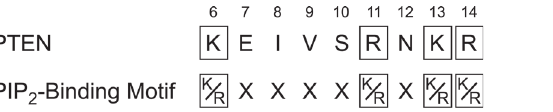
Figure 4. Residues Lys-6 to Arg-14 of PTEN and the canonical PIP 2 -binding motif. Each conserved residue in this motif is altered in cancer according to the COSMIC database.